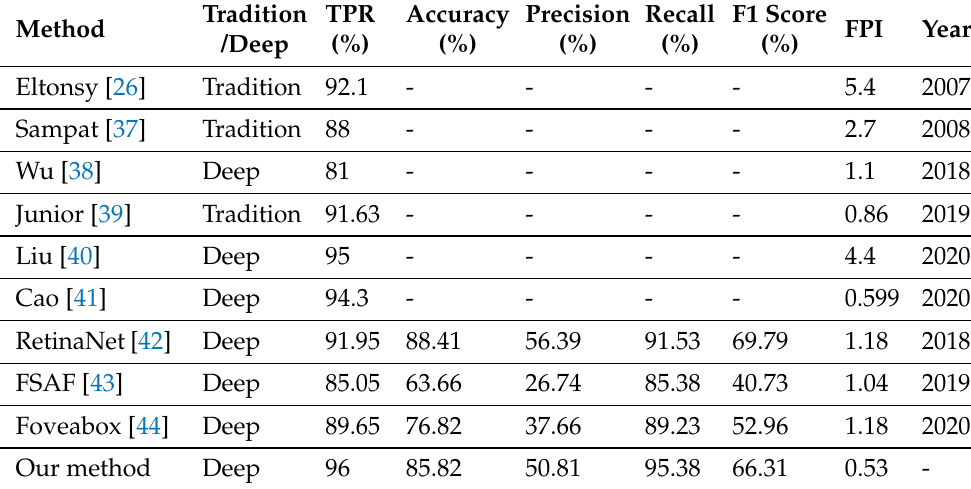
Table 1. Comparison of the detection performance of the proposed method and the state-of-the-art methods on DDSM.